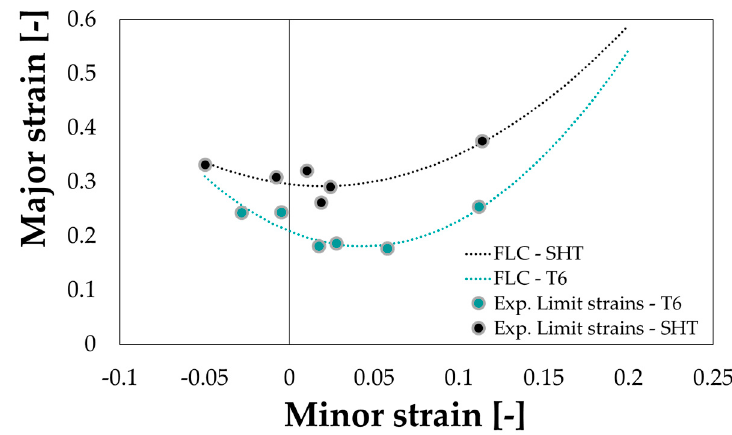
Figure 12. AA6082 Forming Limit Curves.